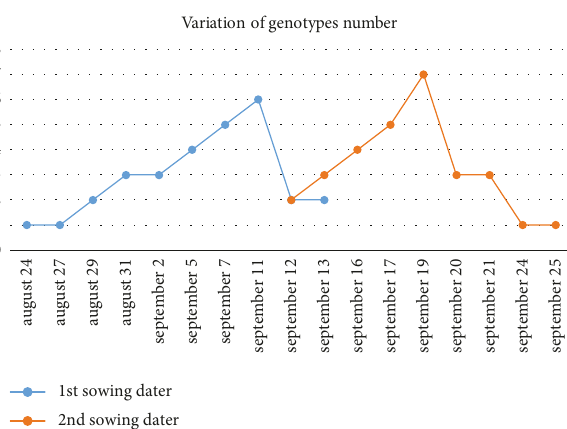
Figure 4: Variation of genotypes number according to the heading date of the accessions during the two sowing dates.